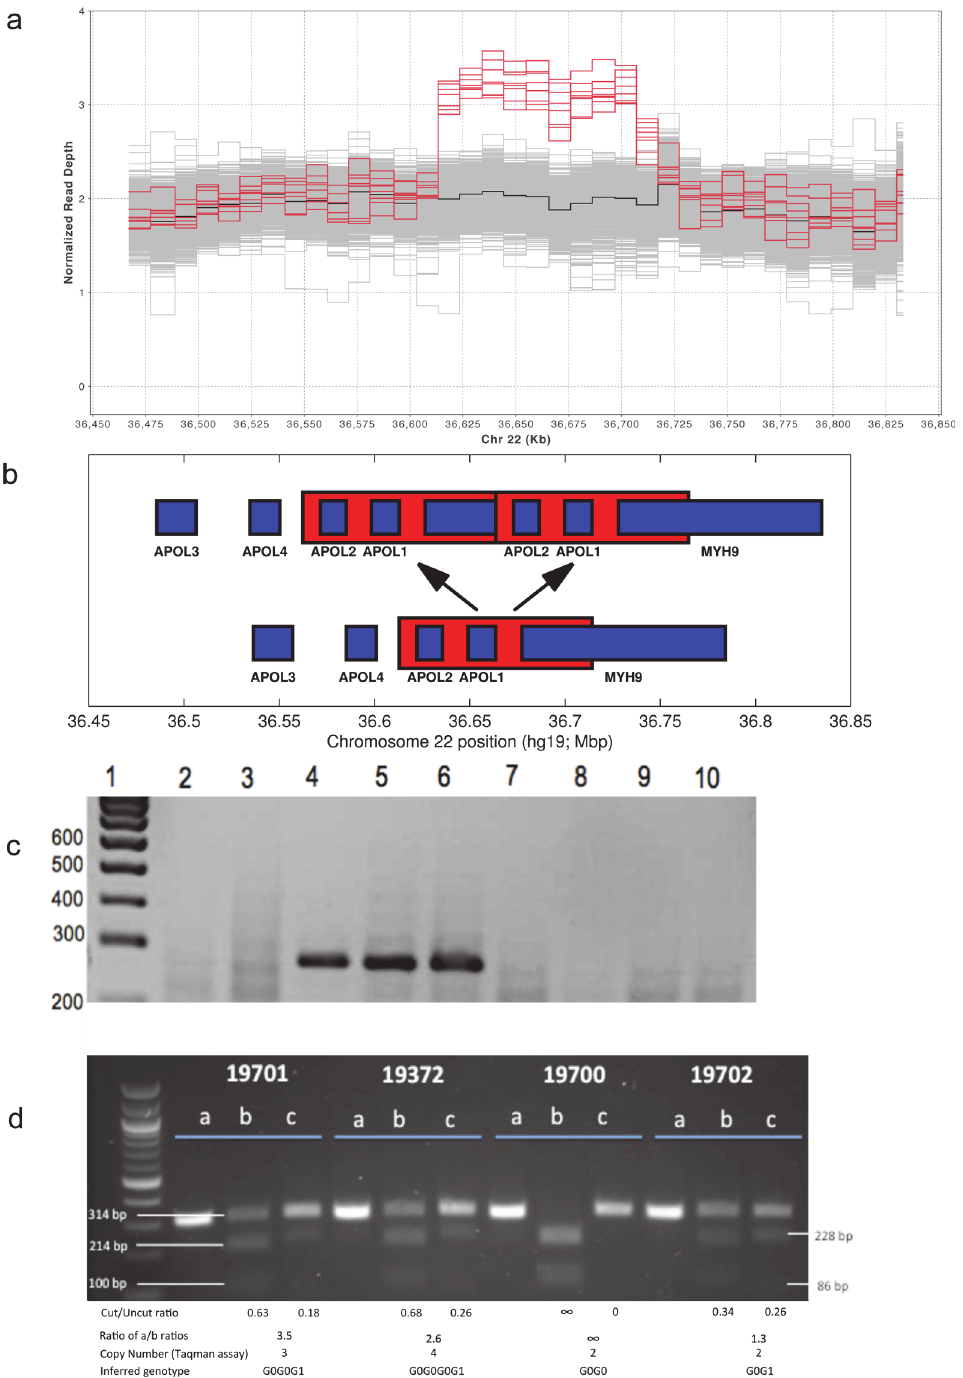
Fig 1. Copy number variation at APOL1 locus. a. Sequence coverage analysis of samples from 1000 Genomes Project. Grey lines are used to depict coverage of each of 2,527 samples at genomic loci to which sequence reads map. Red lines indicate coverage for 8 samples with apparent duplication. The black line depicts median coverage for all samples showing elevated coverage over a region of this locus, including APOL1, suggesting duplication. Coordinates of the genome are plotted on the X-axis against normalized read depth on the Y-axis. Coordinates of APOL1 gene are chr22: 36,649,117 – 36,663,571 (hg19). b. Pictorial representation of the duplication event. An approximately 100kb region of chromosome 22, beginning from a region adjacent to APOL2, and involving all of APOL1 and part of MYH9 is duplicated (chr22:36,612,938 – 36,714,262, hg19). c. Gel electrophoresis (3% agarose) of the PCR product of the qualitative PCR assay used for detection of duplication. The PCR assay amplifies sequence across the junction between the duplicated segments, and results in a 291 bp size product, if present. Lane 1 corresponds to 100 bp ladder with size of each fragment indicated. Lanes 2 and 3 represent